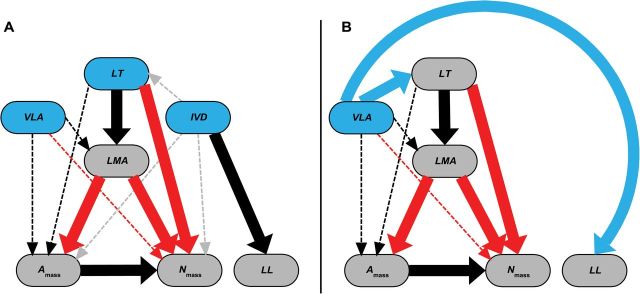
The structure of the ‘vein origin’ model of Blonder et al. (2011), based on eqns 4–7 (see Appendix 1), redrawn to highlight the influences of given variables (leaf mass per area, LMA; photosynthetic rate per mass, A
mass; leaf nitrogen per mass, N
mass; and leaf lifespan, LL; leaf thickness, LT; vein length per area, VLA; interveinal distance, IVD). This schema shows only the measured traits; other variables that were treated as constants are not included. Raw input traits are depicted in blue ovals; output traits are depicted in grey ovals (these are used as inputs for estimating other traits). The two panels show the contrasting implementation of equations for (A) prediction of leaf economics spectrum (LES) traits, and (B) for simulation of LES relationships. Black arrows represent positive influence according to eqns 4–7, red arrows negative influence. The thick arrows indicate the important drivers, and the thin dashed arrows represent negligible effects, according to sensitivity analyses (Table 2) and randomization analyses (Sack et al. 2013); the grey dotted arrows linking IVD to most variables represent drivers apparent in the equations that cancel out when the equations were rewritten as eqns 4a, 5a and 7a. When the model was implemented for prediction (A), LT, VLA, and IVD were inputted, and the estimates of LES traits were driven by measurements of LT, which resulted in weak relationships among the estimated LES variables and weak correlations between estimated and observed values for LES traits, independently of vein trait inputs, which have negligible effects in these equations. When the model was implemented for simulation (B), VLA was used to directly determine LT and LL, not reflecting a real mechanism, indicated by blue arrows. Thus, the input of VLA drove all output traits in the simulation, forcing the predetermined outcome in which VLA appears to drive LES trait relationships.